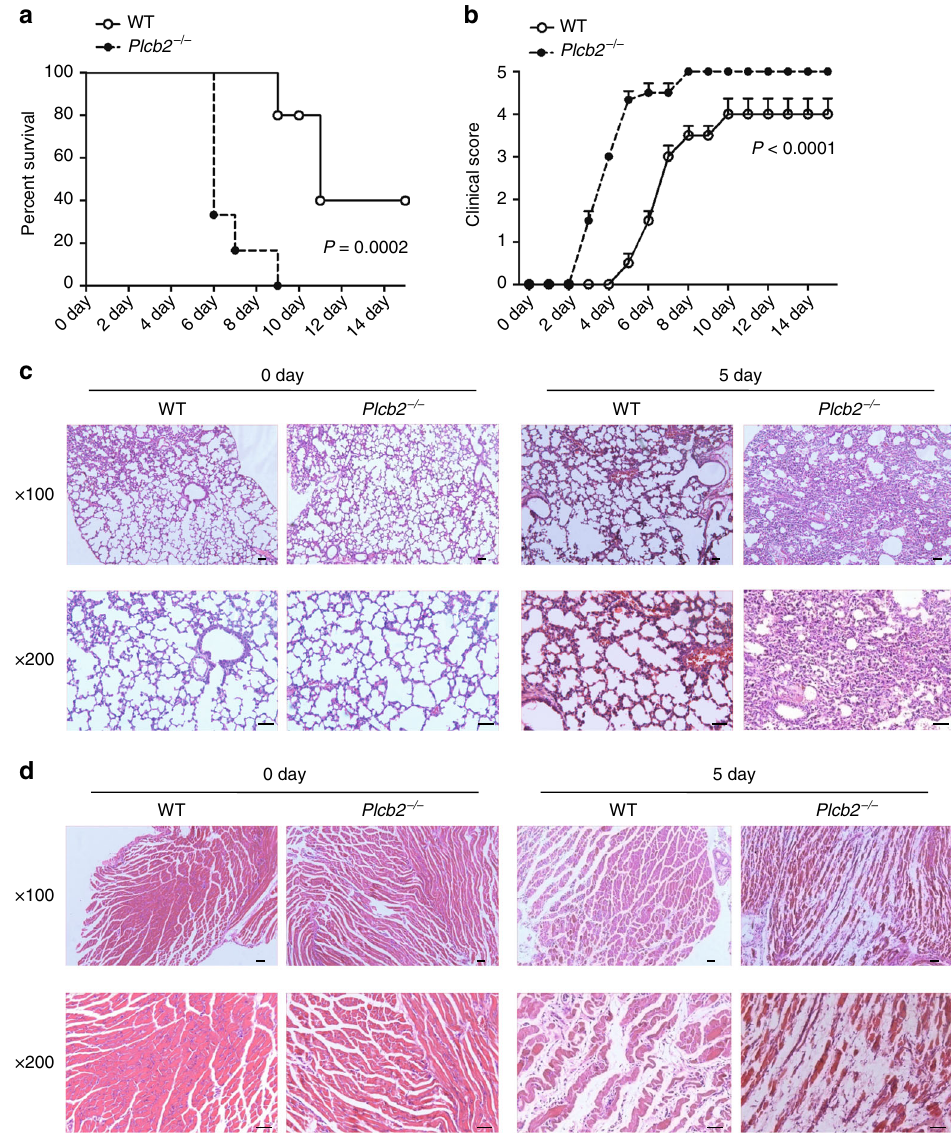
Fig. 6 PLC β 2-de fi cient mice are more susceptible to CVA16 infection. Fourteen-day-old wild-type or Plcb2 − / − mice were infected intraperitoneally with 50 μ l of CVA16 (1.5 × 10 4 PFU/mouse) for 0 or 5 days. Survival ( a ), clinical score ( b ), or histopathology of lung ( c ), or skeletal muscle ( d ) tissue of wild-type or Plcb2 − / − mice ( n = 6) treated as indicated. Scale bar, 50 μ m. Data are representative of three experiments with at least three independent biological replicates (mean and s.e.m. of n = 6 mice per group). Gehan – Breslow – Wilcoxon test ( a ) and two-way analysis of variance plus Bonferroni ’ s posttest ( b ) were used to calculate p